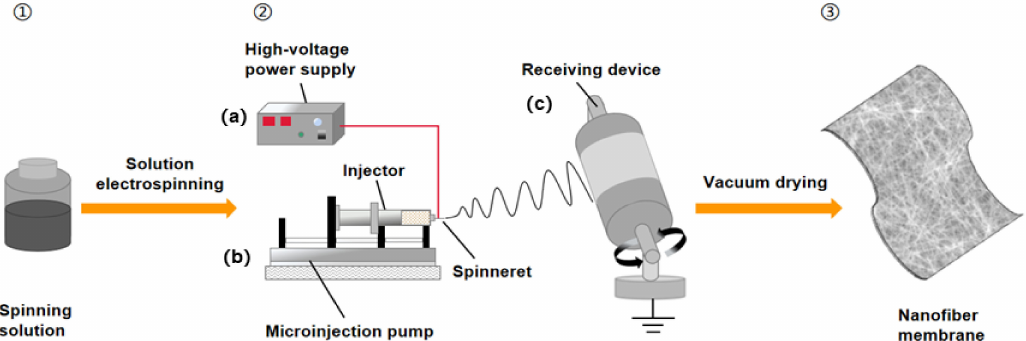
Figure 1. Schematic diagram of far-field electrospinning. 1 (cid:13) Spinning solution; 2 (cid:13) Electrospinning de- vice ( a ) High voltage DC power supply; ( b ) Liquid supply device; ( c ) Collecting roller; 3 (cid:13) Electrospun nanofiber